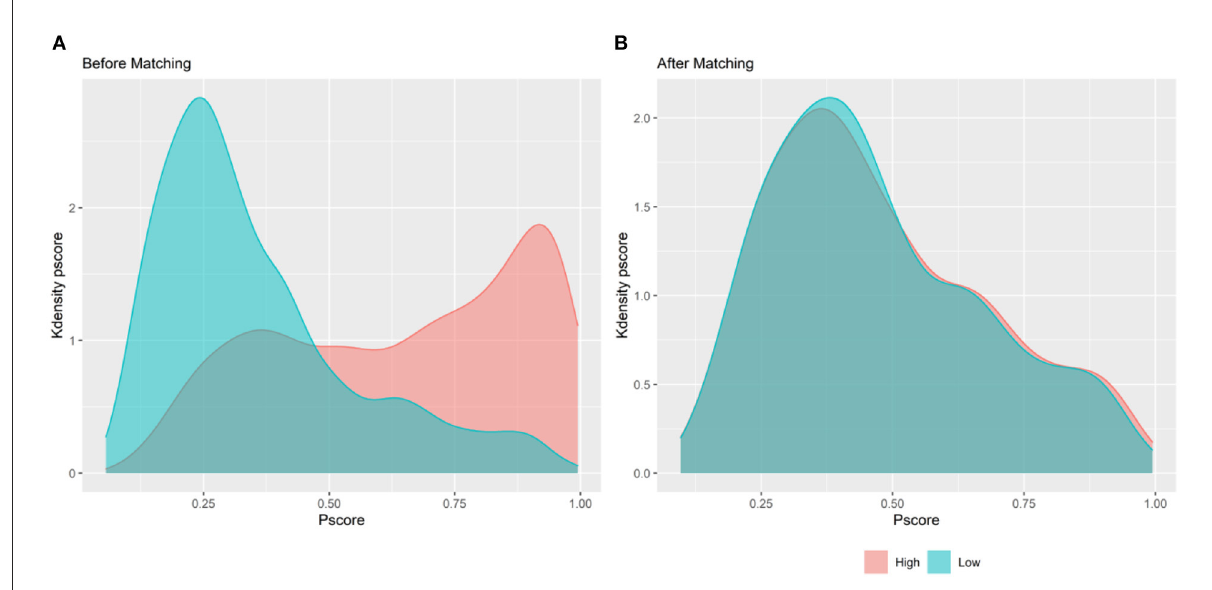
FIGURE2 Kdensity distribution of propensity score. (A) Before PSM; (B) after PSM.